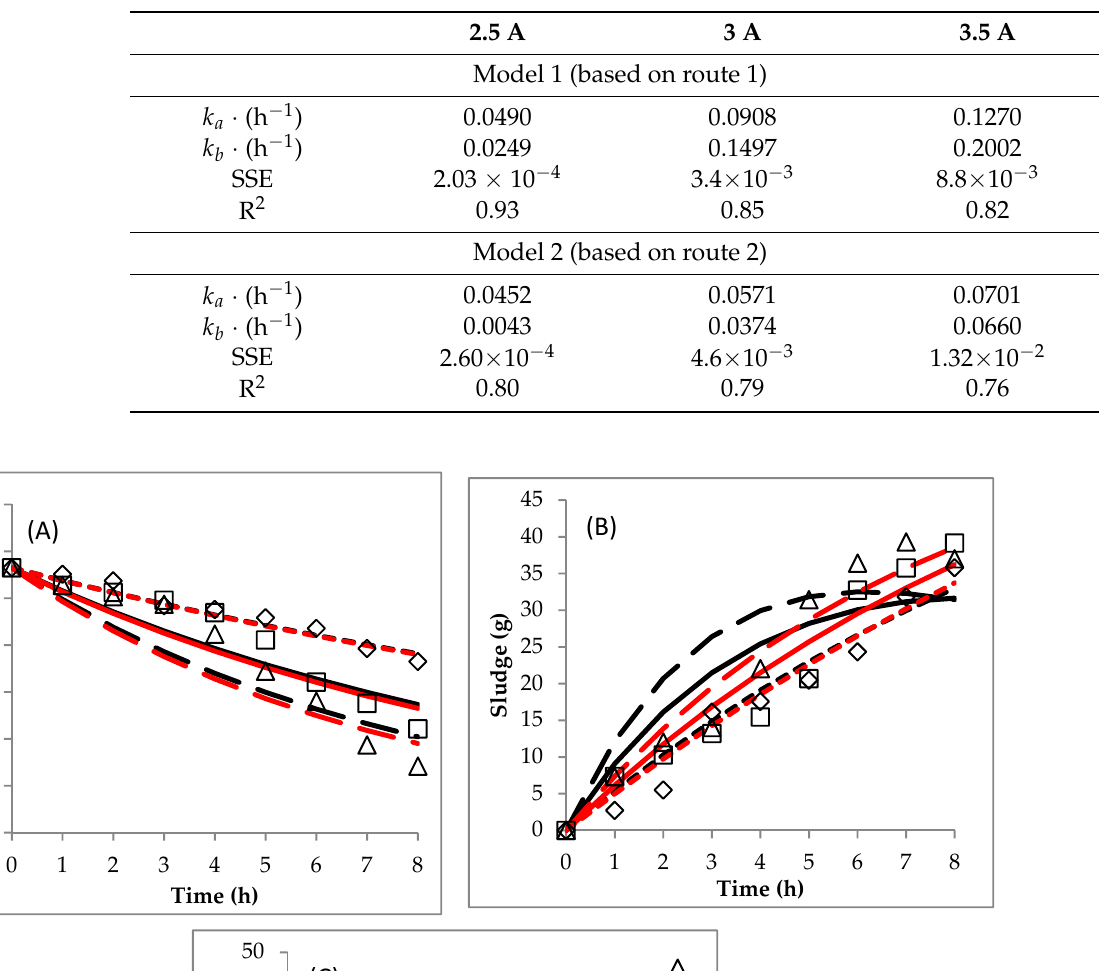
Table 3. Kinetic constants for the EC at various currents.